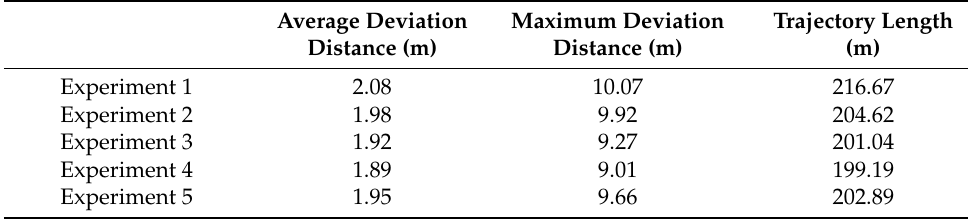
Table 1. Five groups of experiments before